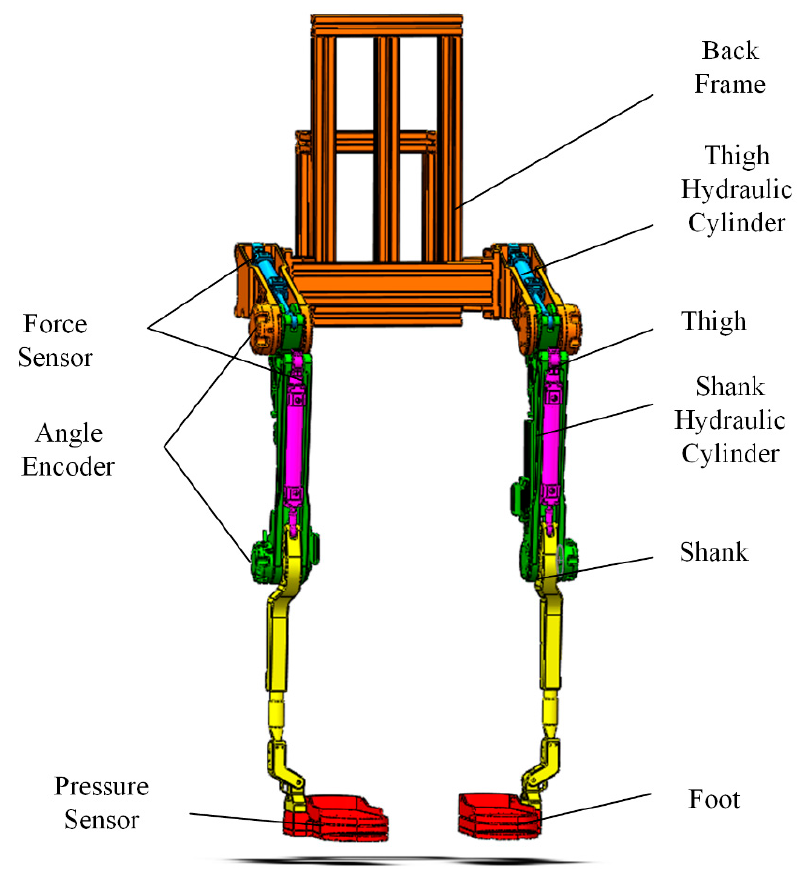
Figure 9. The whole structure for the exoskeleton.